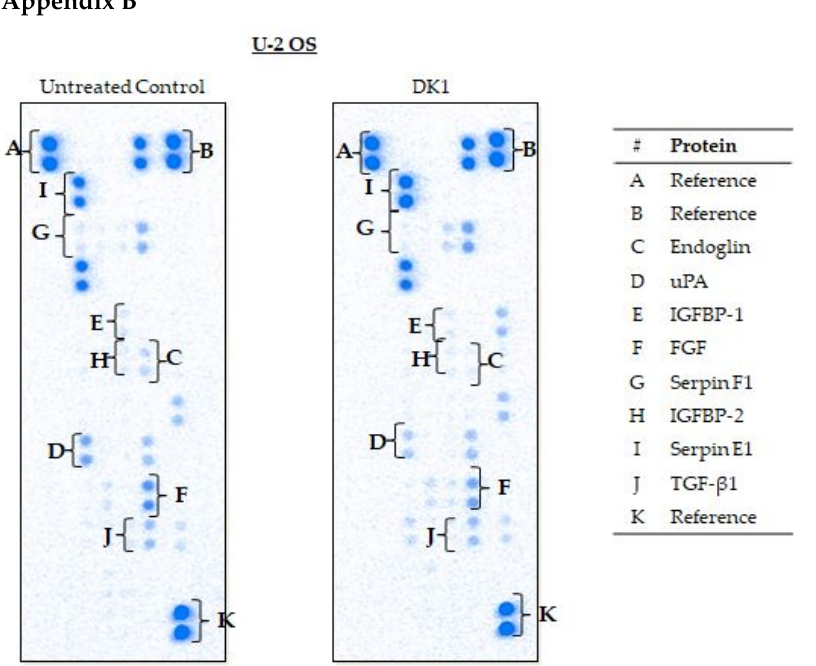
Pharmaceuticals 2021 , 14 , x FOR PEER REVIEW 20 of 22 Figure A1. The proteome profiler membrane that exhibits the expression of metastasis-related proteins